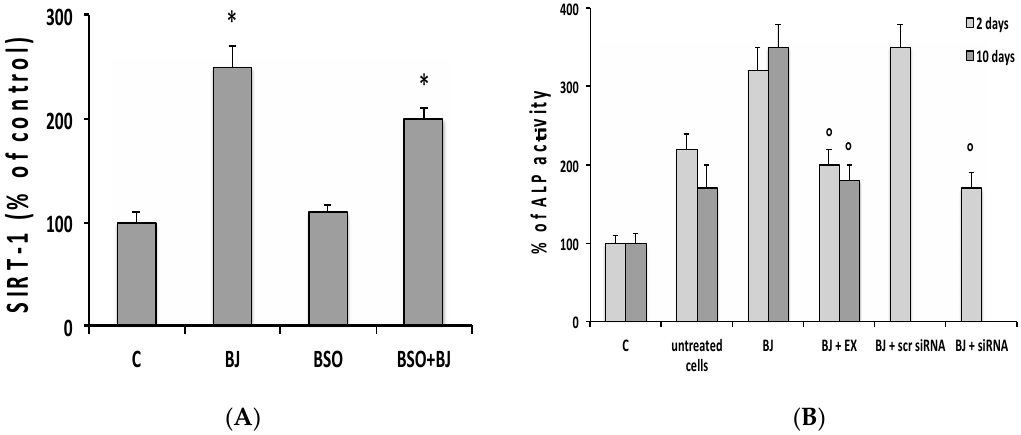
Figure 5. BJ effect on sirtuin type 1 (SIRT1) expression and SIRT1 inhibition role in BJ-induced ALP activation during differentiation of SaOS-2 cells. SIRT-1 expression ( A ) and ALP activity ( B ) were detected in SaOS-2 cells treated or not with BJ at 15 μ g ∙ mL − 1 total soluble polyphenols (TSP) or BSO, BSO + BJ, or BJ + EX527, for one day in growth medium (GM) and, subsequently, in osteogenic medium (OM), in the presence or not of various treatments, as reported in Section 2. SIRT1 expression was detected after six days in OM by ELISA kit according to the manufacturer’s instructions, and levels are expressed as a percentage of the C values (A). ALP activity was also detected after two and 10 days in GM (control, C) and OM, as well as in transfected SIRT1 small interfering RNA (siRNA) or Scr RNA cells after two days in OM. SIRT1 expression and ALP activity values are expressed as a percentage of the respective C values, and they are the means ± SEM of three independent experiments; * p ≤ 0.05 compared to C cells; ○ p ≤ 0.05 compared to BJ-treated cells.